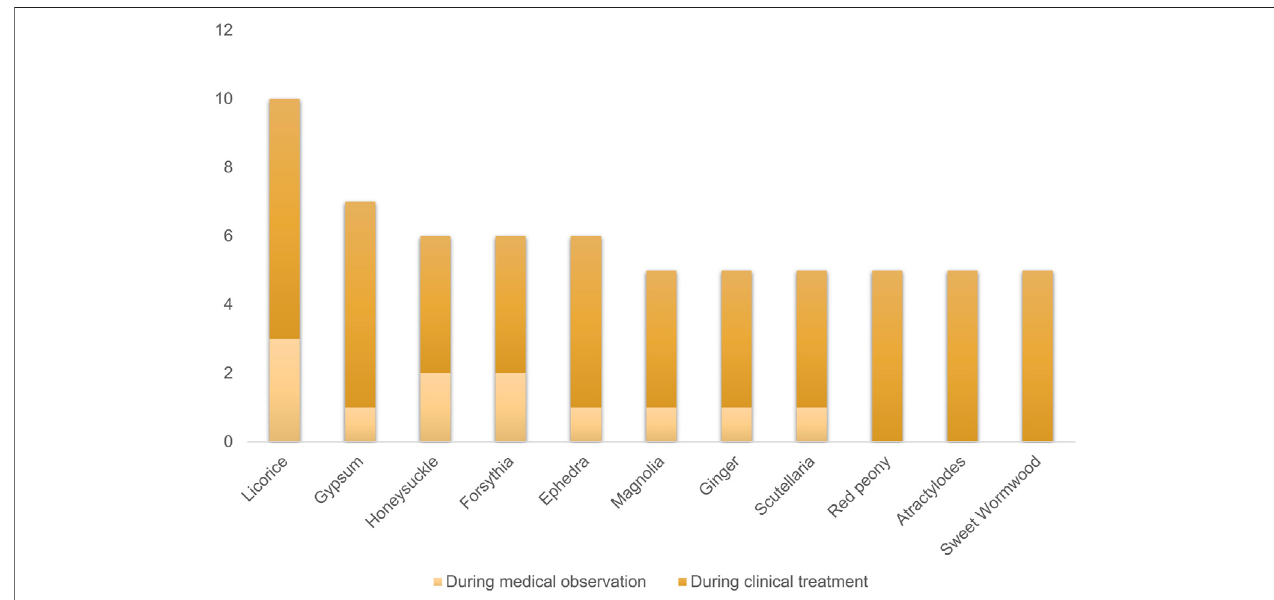
FIGURE 1 | The top 10 most frequently used herbs among the recommended Chinese medicine formulas for COVID-19 treatment.